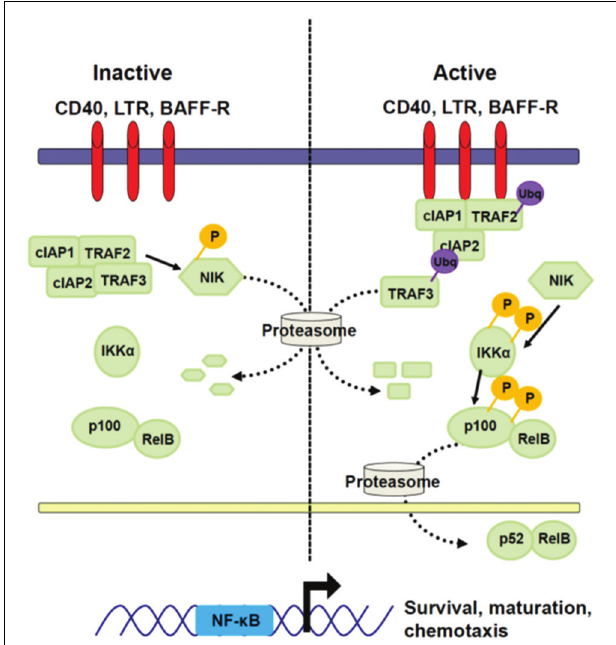
FIGURE 3 | Non-canonical NF- κ B signaling. Non-canonical NF- κ B signaling is initiated by the binding of cell surface receptors to their ligands. Trimerization of the receptors recruits TRAF2, cIAP1, and cIAP2 to the receptor. This changes the specificity of cIAP1/2 ubiquitin ligation from NIK to TRAF3. TRAF3 is ubiquitinated by this complex and degraded by the proteasome. The absence of TRAF3 prevents degradation of NIK, leading to its accumulation. NIK can phosphorylate IKK α . Activated IKK α phosphorylates p100, inducing its partial degradation by the proteasome. The processed p100 subunit, p52, associates with RelB and translocates into the nucleus where it mediates transcription of pro-survival